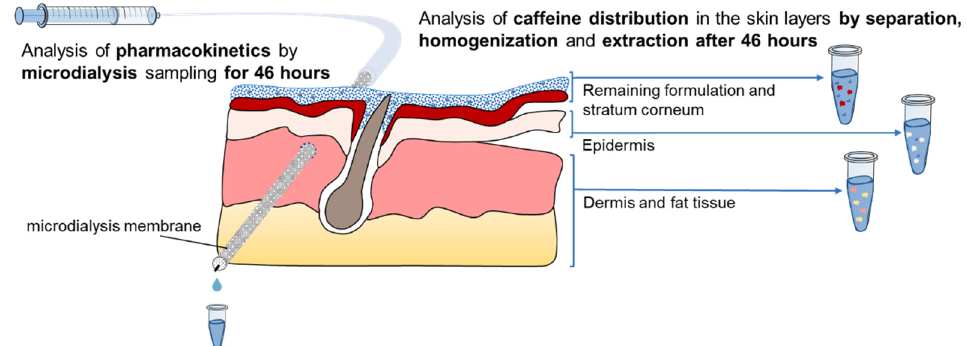
Figure 2. Dermal microdialysis and skin separation, homogenization and extraction were performed in parallel on the porcine ear skin. The dermal microdialysis is able to capture the pharmacokinetics of the applied formulations, while the skin separation, homogenization and extraction technique captures the caffeine distribution in the skin layers at one time point.